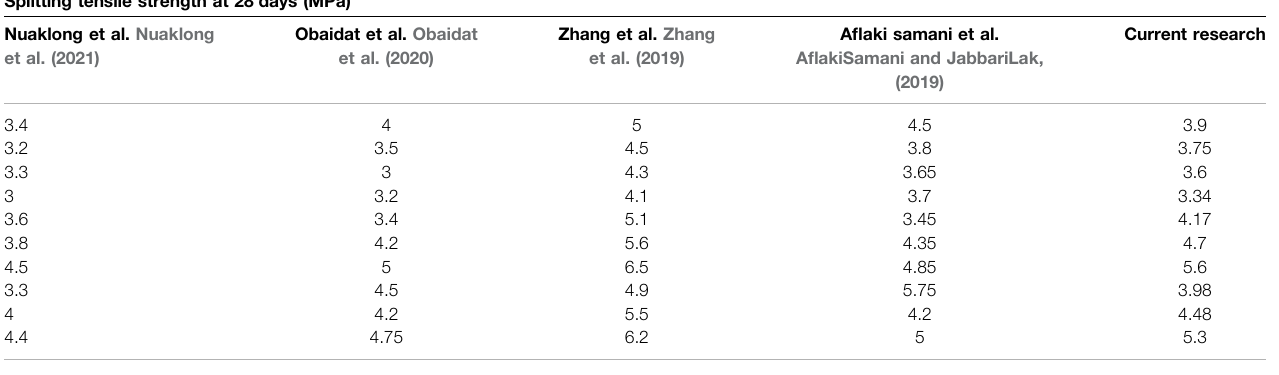
TABLE 6 | Values of splitting tensile strength from present literature and the current research. Splitting tensile strength at 28 days (MPa)